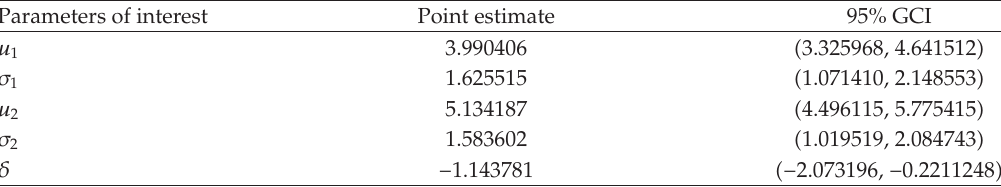
Table 4: Numerical results for the cloud seeding